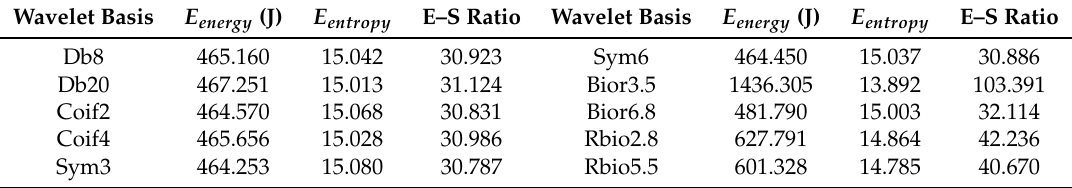
Table 2. The results of wavelet packet decomposition based on different wavelet basis functions.